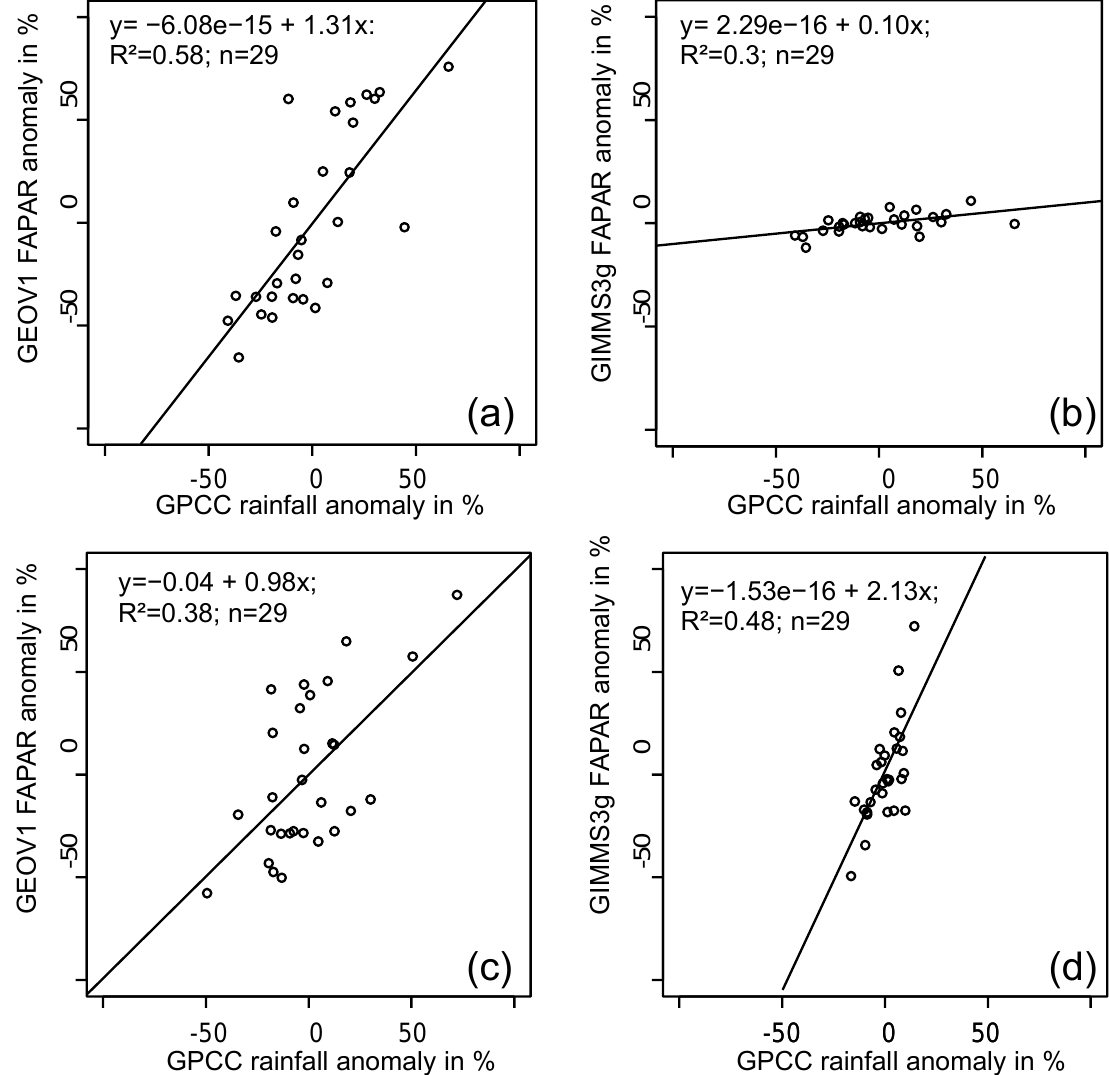
Figure 9. Scatterplots showing relationships between annual rainfall (GPCC) and annual FAPAR anomalies averaged over the study areas around Bandiagara ( a , b ) and Lingu`ere ( c , d ) for the period 1982–2010 (29